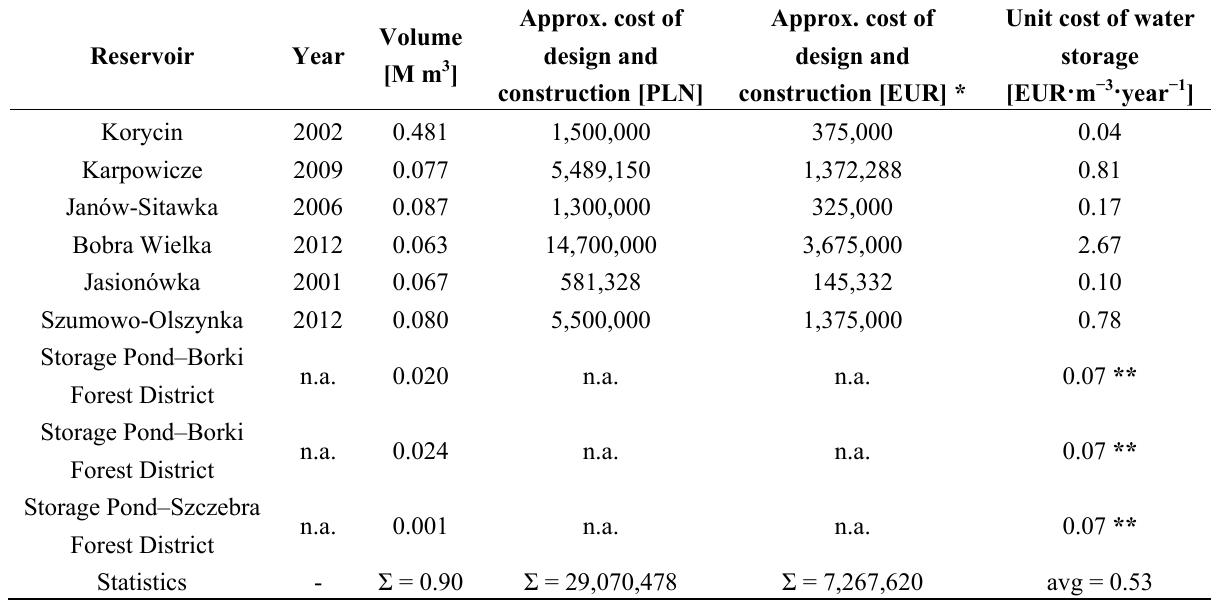
Table 1. Artificial storage ponds considered in the economic assessment of unit cost of water storage in the catchment of Biebrza. * Currency exchange rate used in the analysis 1 EUR = 4 PLN; ** approximate value calculated on the basis of Tyszka [19]. Explanation in